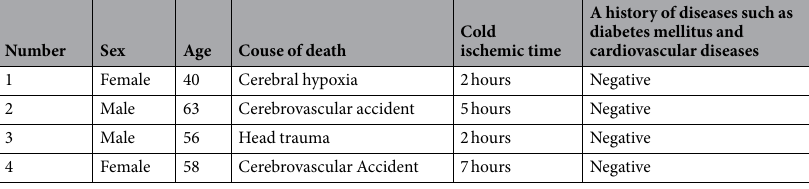
Table 1. Characteristics of the pancreas